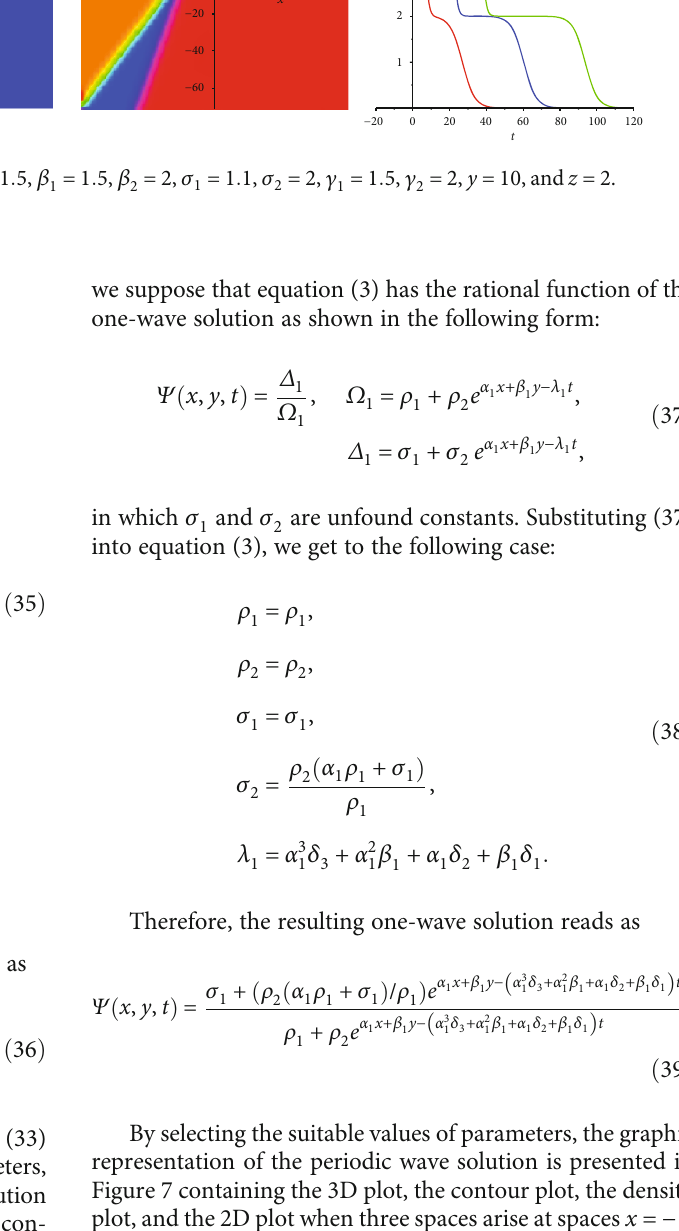
Figure 5: The two-wave solution (31) at α